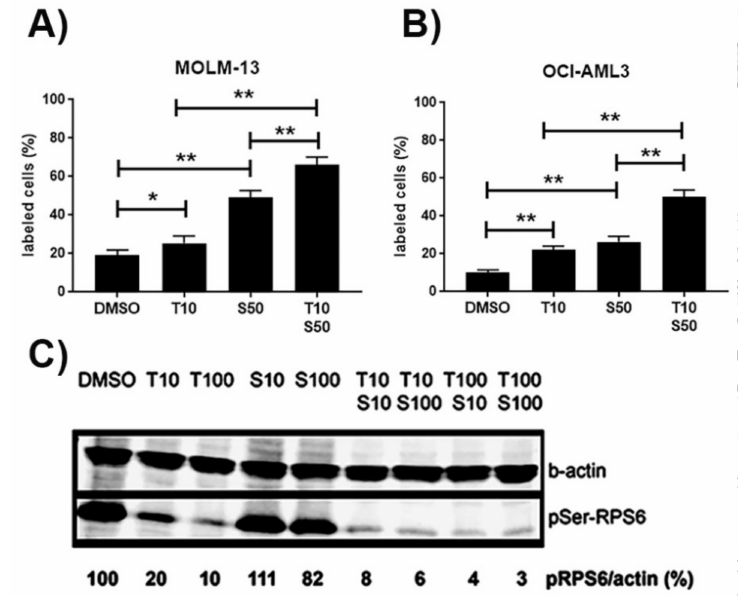
Figure 2. Cellular and molecular e ff ects in AML cells treated with S63845, HDM201, and trametinib. Increase in the percentage of annexin positive apoptotic cells based on cytometric analysis in the AML cell lines MOLM-13 ( A ) and OCI-AML3 ( B ) treated for 20 h with single compounds or with combination treatment. Reduced levels of phospho-Ser-RPS6 ( C ) in OCI-AML3 cells treated with the indicated amounts of S63845 (S, nM) and trametinib (T, nM). Representative Western blot of total protein extracts detecting pSer-RPS6 and β -actin. Significance is denoted for p < 0.05 (*); p < 0.005